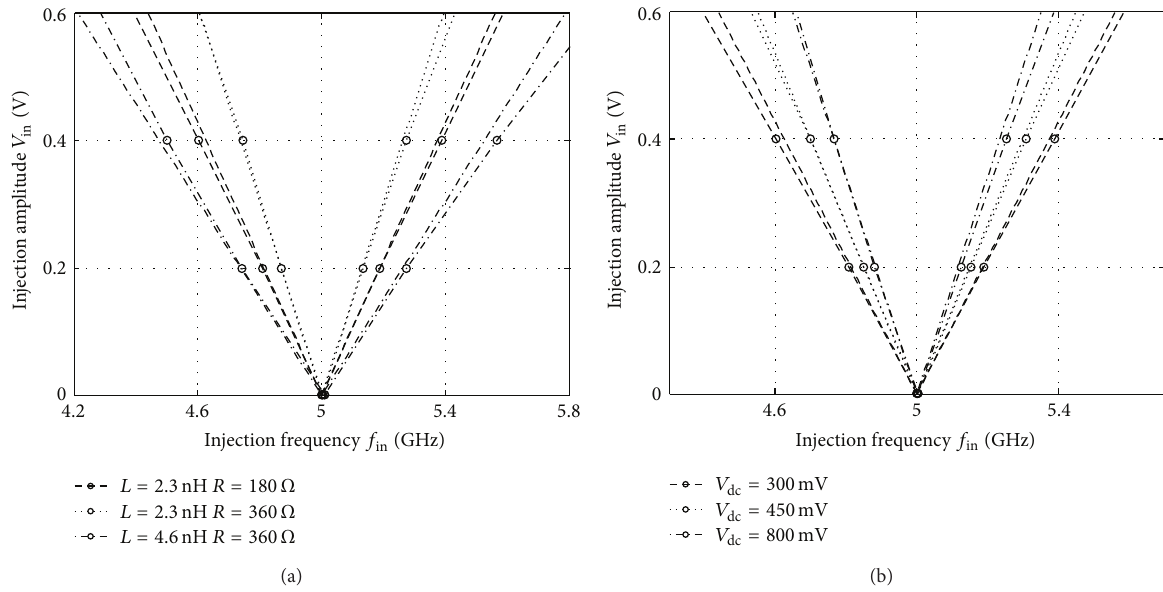
Figure 4: Boundaries of the locking ranges for an ILFD with the polynomial nonlinearity in (15) for different values of passive parameters and feedthrough entity. Results are obtained by SPICE simulations (lines with circles) and by (16) (lines without circles). Circuit parameters are the following: 𝐿 = 4 nH, 𝑅 = 400 , 𝜔 0 = 1.8 GHz, 𝑎 1 = 1/40 , 𝑎 3 = 5/96 , and 𝑉